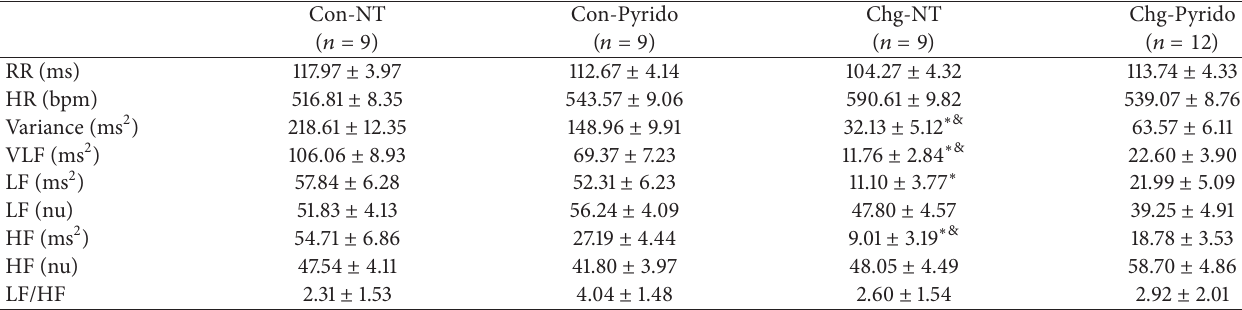
Table 3: Heart rate variability after treatment with pyridostigmine bromide. Heart rate variability parameters (expressed as mean ± S.E.M.) collected at the 6th month of observation and after one month of treatment (from the 5th to 6th month of infection) in noninoculated control (Con) or T. cruzi- inoculated (Chg) freely moving C57BL/6j mice treated with pyridostigmine bromide (Pyrido) or vehicle (NT: nontreated